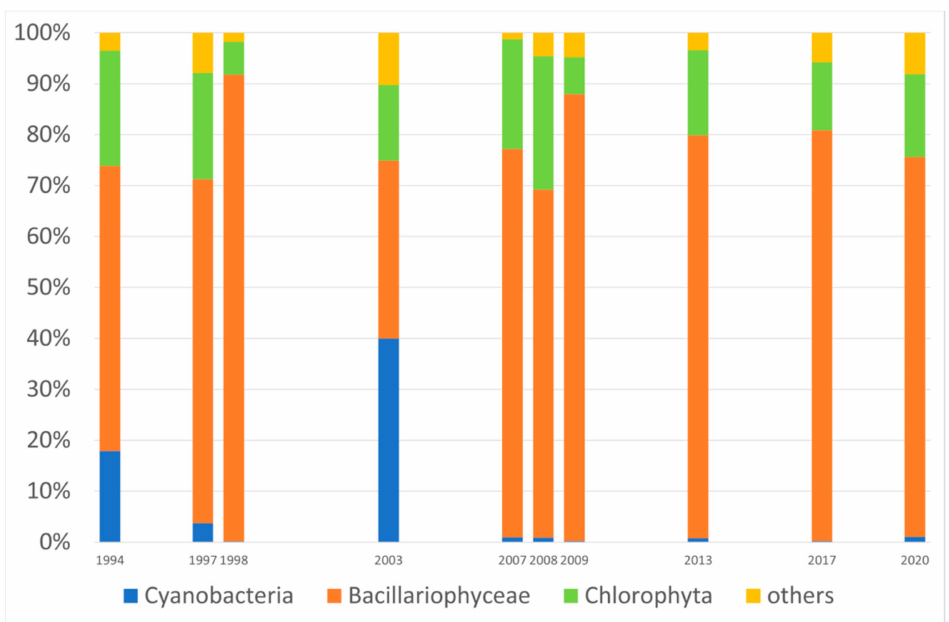
Figure 4. Percentage share of phytoplankton groups during the investigation period. In the 1990s, the values of the multimetric phytoplankton index for rivers indicated the poor ecological potential of the Vistula (in 1994 and 1997, this value was slightly over 0.4). Only in 1998 did the phytoplankton index (IFPL) indicate a moderate ecological potential of the river, with an IFPL value of 0.550 (Figure 5). In the years 2007–2009, the average value of the trophic index increased to over 0.8 and indicated good ecological potential. The maximum value of the IFPL index was noted in 2008 and amounted to 0.870. In the years 2013–2020, the values of the ecological potential of the Vistula’s waters in Toru´n indicated moderate conditions, with IFPL values over 0.7. The trend line indicates a gradual, very strong (R 2 = 0.52) improvement in water quality in the period from 1994 to 2020.